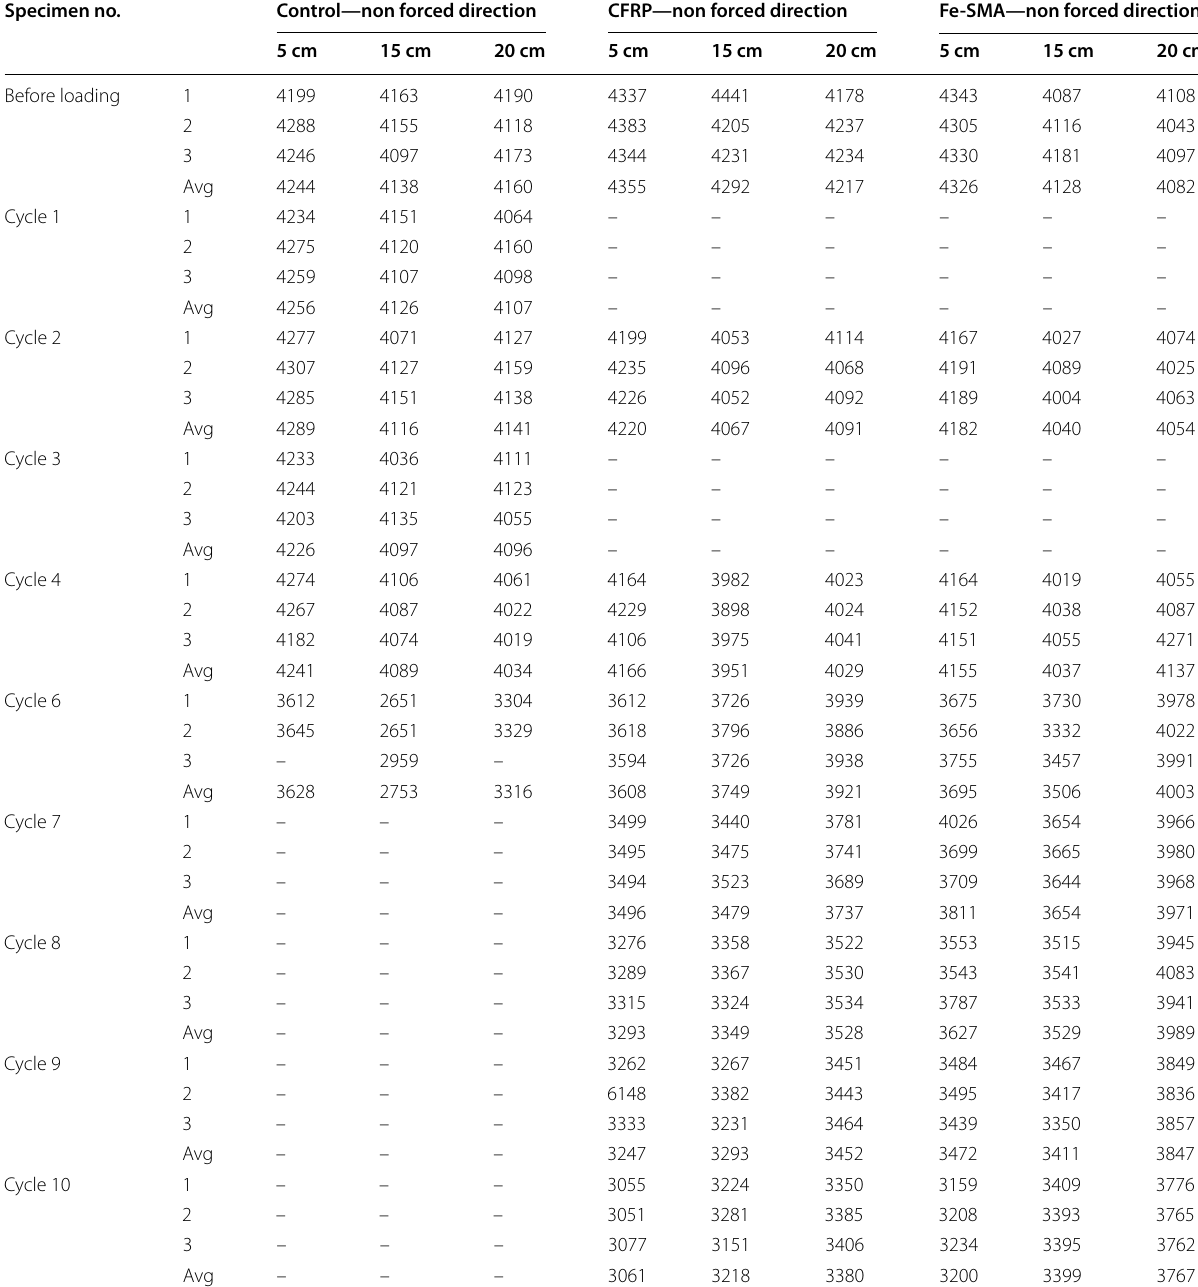
Table 5 UPV data: non-forced direction Specimen